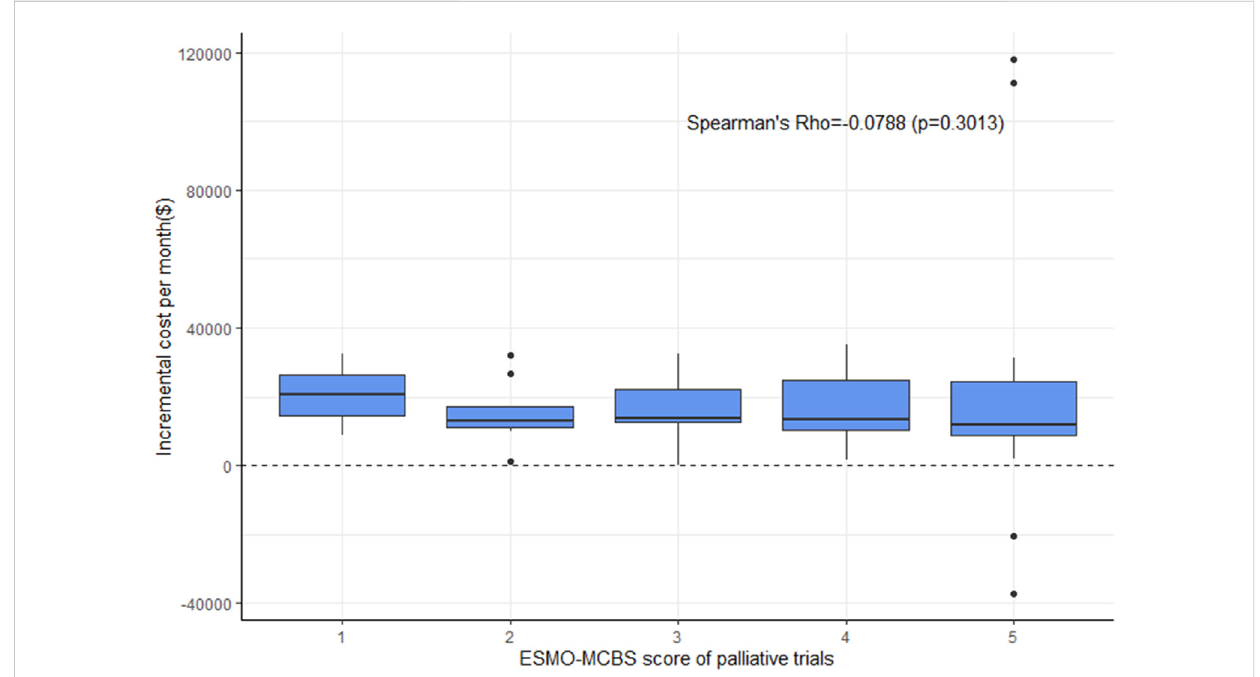
FIGURE 3 Boxplot of correlation between ESMO-MCBS scores and incremental cost per month in palliative trials.